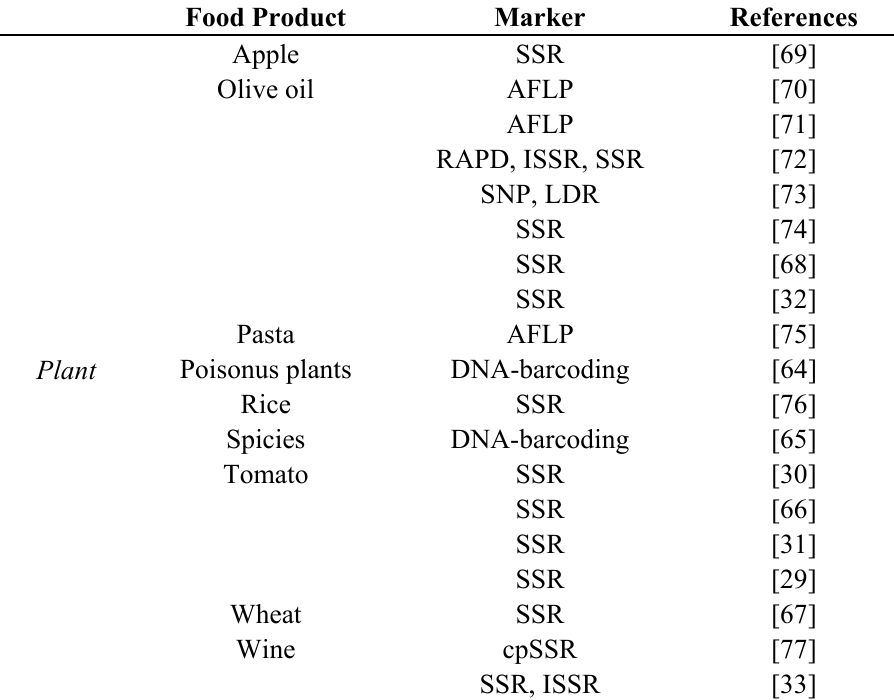
Table 1. Examples of the use of DNA markers in the analysis of food